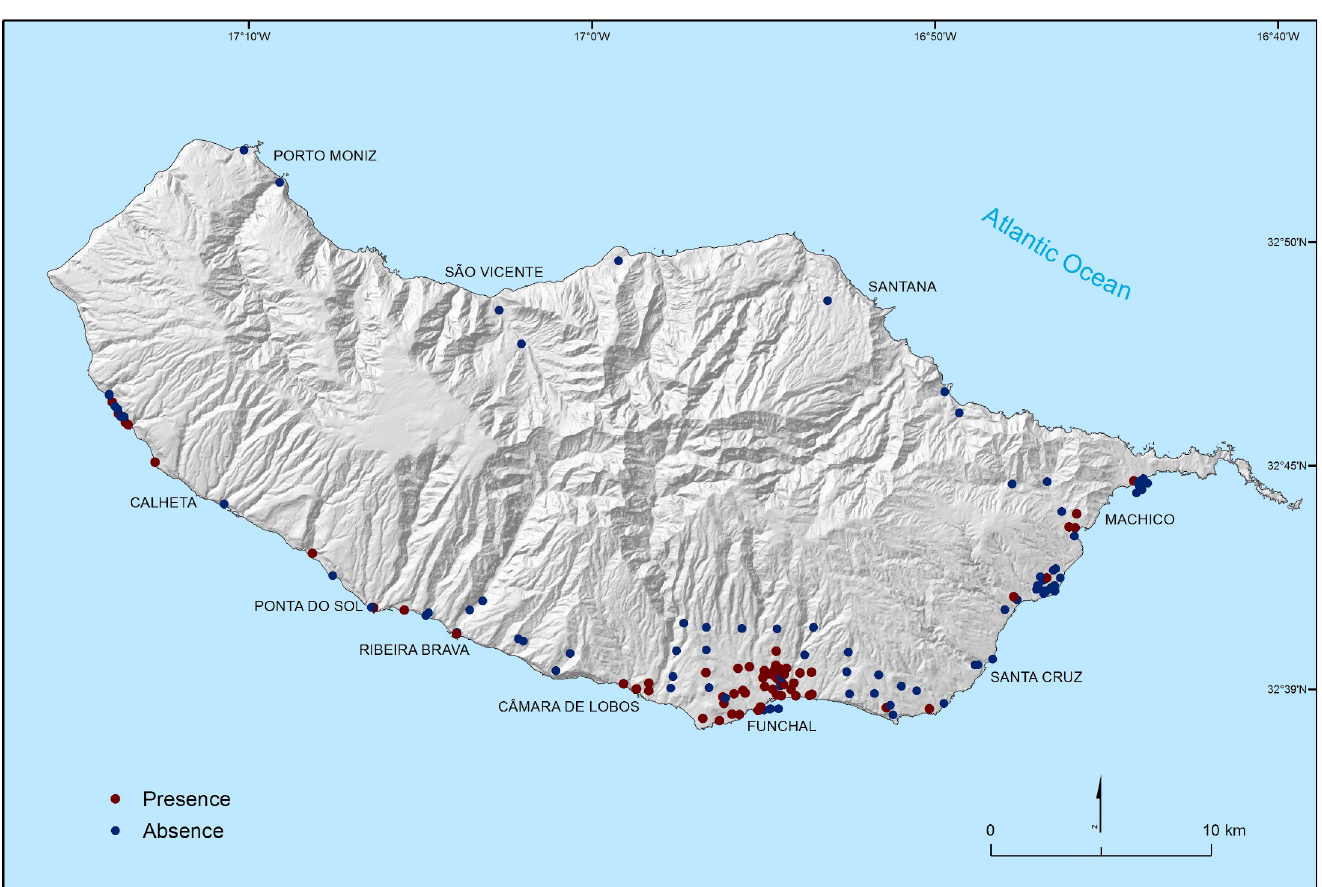
Fig 2. Spatial distribution of mosquito traps existing along the island and recorded presence or absence of Aedes aegypti mosquitoes (source of shapefile: https://www.dgterritorio.gov.pt/cartografia/cartografia-tematica/caop).